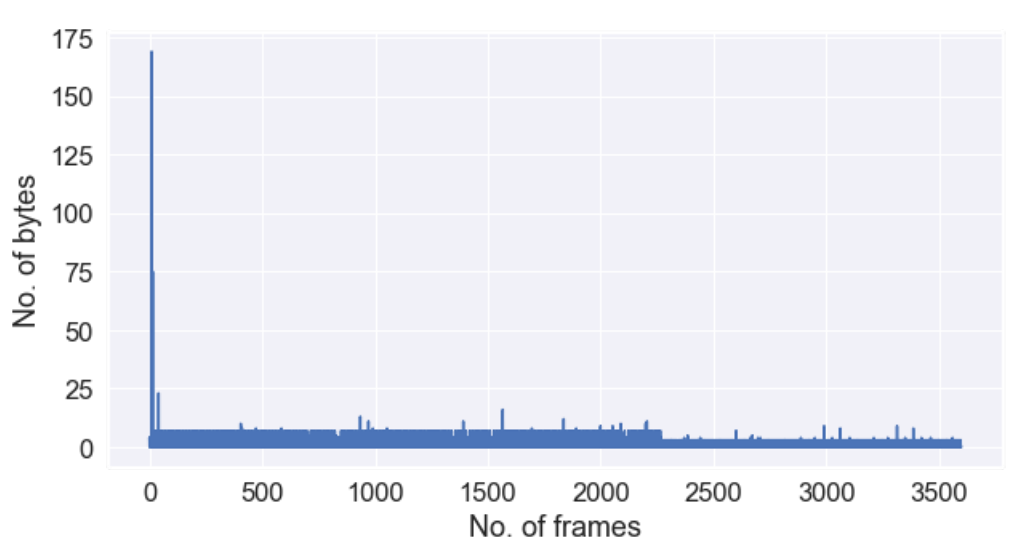
Figure 24a. I/O read requests S2.3.